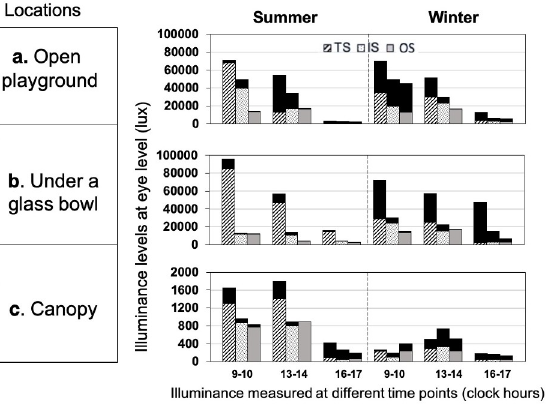
16:00–17:00 hours). The dark shaded area on the top of each bar represents the difference in illuminance levels obtained on two different